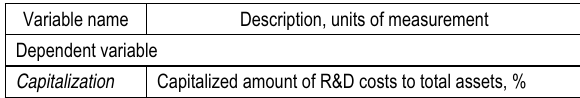
Table 1. Research